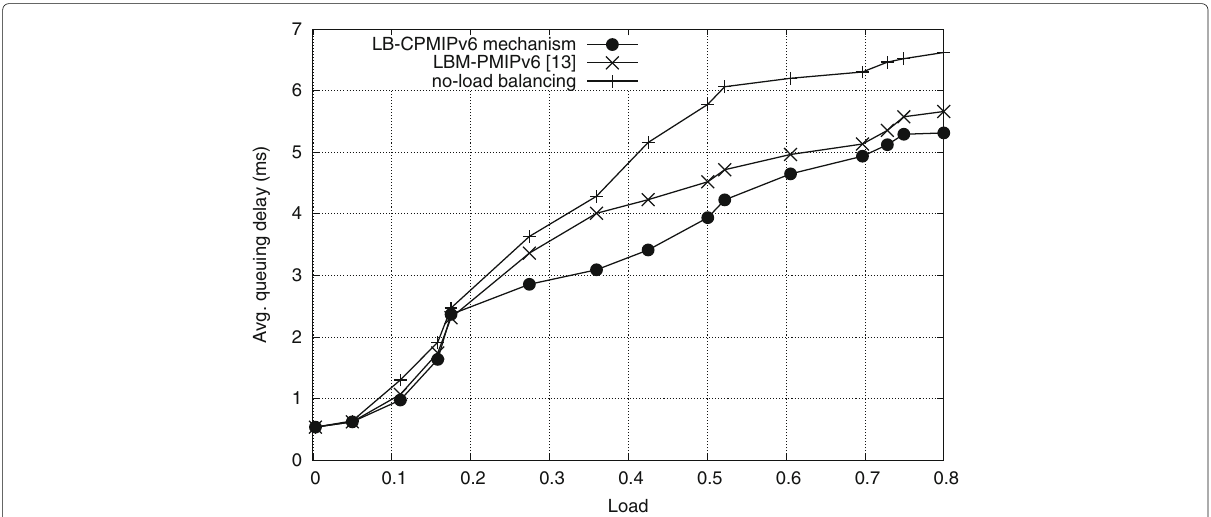
Fig. 16 The average queuing delay obtained from the third